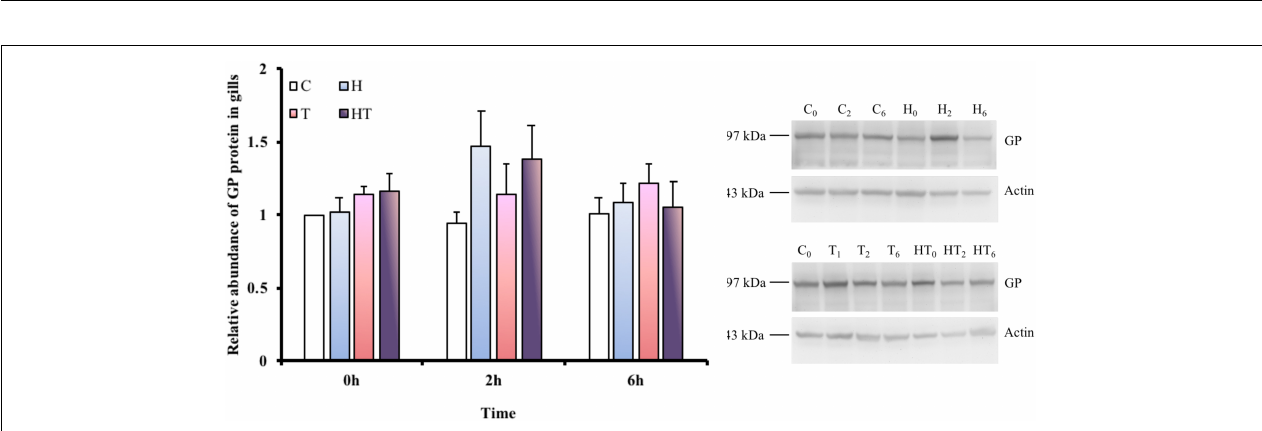
FIGURE 3 | Lactate concentration in gills of M. opercularis : (A) in control (C), hypoxic (H), thermal (T), and hypoxic-and-thermal (HT) ABR treatment groups at 0, 2, and 6 h ( n = 9–11); (B) in control (C), restricted (R), hypoxic (HR), and thermal (TR) ABR-restricted treatment groups at 0 h, 10 min, 2 h and 6 h ( n = 7–10). Values that were significantly different ( p < 0.05) among treatments and times are indicated by lowercase letters. Data are presented as mean ± SEM.